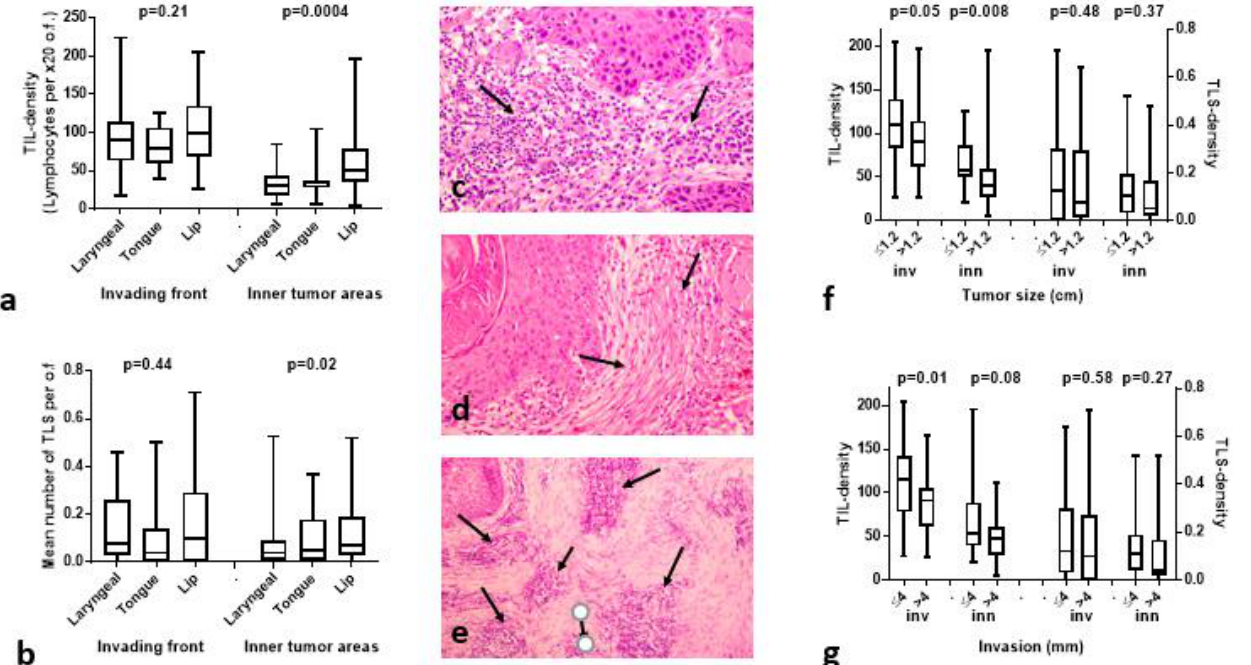
Figure 1. TIL, TLS densities, and histopathological variables. Box and whiskers show the median, range and 25th/75th percentiles: ( a ) comparison of TIL density in the invading front and inner tumor areas according to tumor location; ( b ) comparison of TLS density in the invading front and inner tumor areas according to tumor location; ( c ) high TIL density in the invading tumor front of a lip carcinoma in a H&E tissue section (arrows) at × 20 magnification; ( d ) low TIL density in the invading tumor front of a lip carcinoma in a H&E tissue section (arrows) at × 20 magnification; ( e ) a typical image of a TLSs in the invading front of a lip carcinoma in a H&E tissue section at × 20 magnification; ( f ) TIL and TLS density according to the tumor size, in the invading front (inv) and inner tumor areas (inn); ( g ) TIL and TLS density according to the depth of cancer invasion, in the invading front (inv) and inner tumor areas (inn).